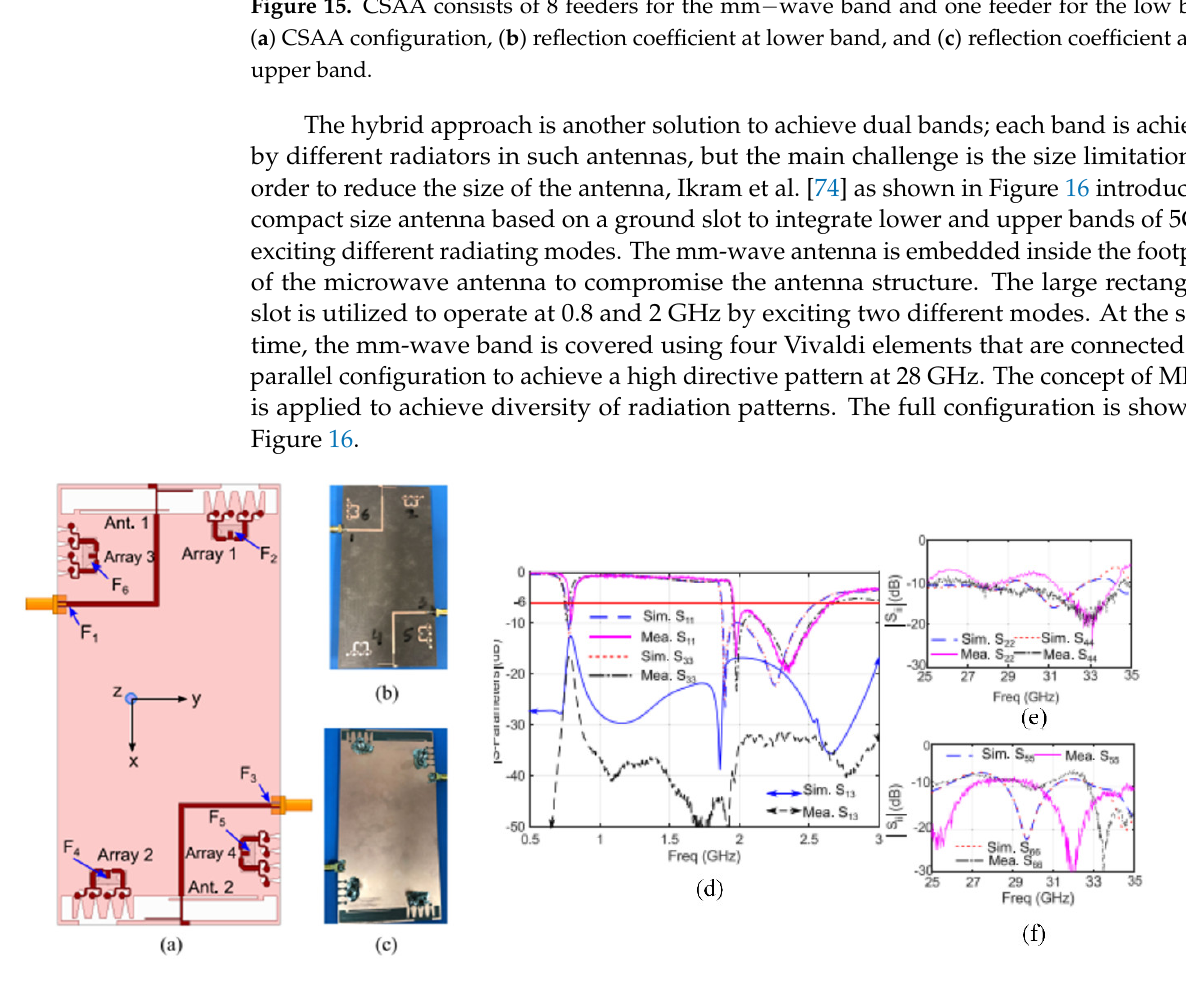
Figure 16. ( a ) Configuration of MIMO antenna, ( b , c ) are top and bottom views of the proposed antenna, and ( d – f ) simulated and measured S − parameters of the MIMO antenna [74] .